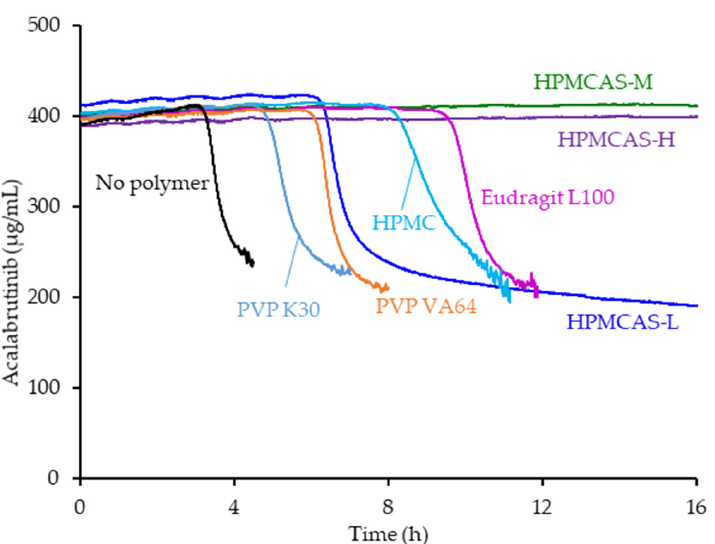
Figure 1. Acalabrutinib concentration versus time in pH 6.5 phosphate buffer containing 6.7 mM FaSSIF powder and 82 mM NaCl measured in the absence and presence of 200 µg/mL dissolved polymer.